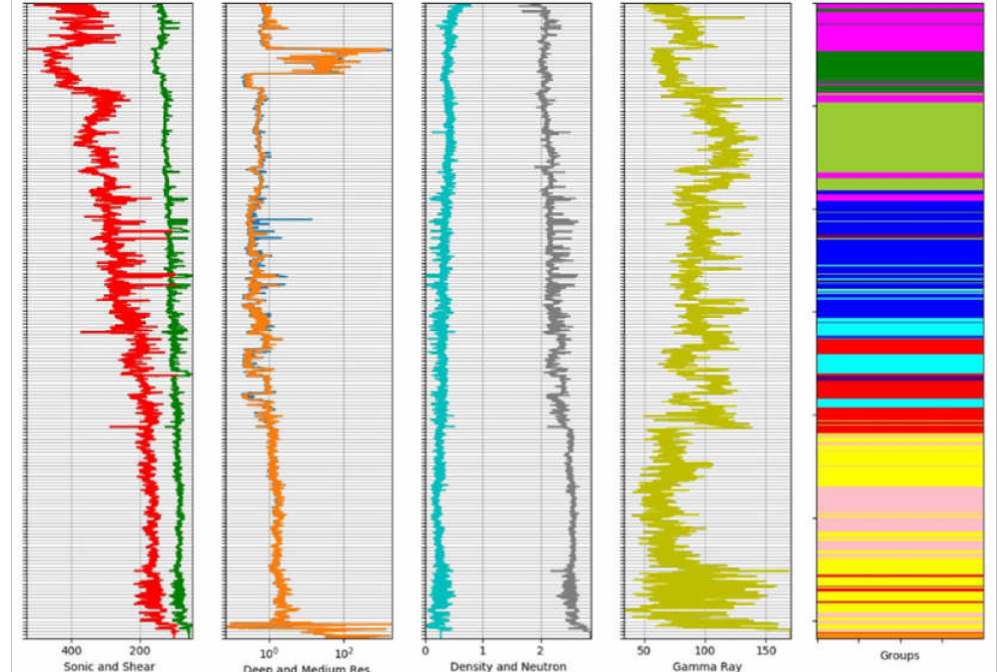
Figure 19. Groups obtained using k-Means (rightmost column) for 10 groups and a window of 6 m for well logs (from left to right, Sonic/Shear, Deep/Medium Resistivity, Density/Neutron and Gamma Ray). Clearly, the main lithologic groups (indicated by changes in well log patterns and values) were well defined by